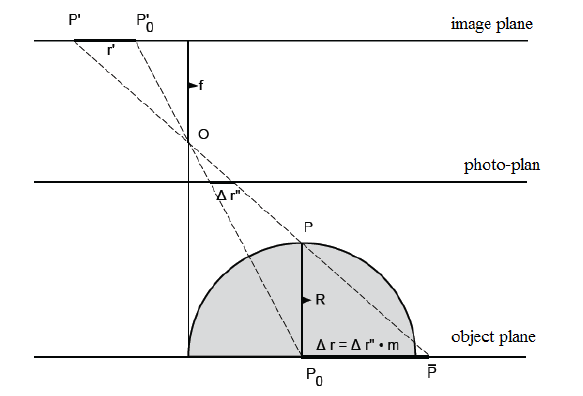
Figure 1. Cylindrical shape affects the